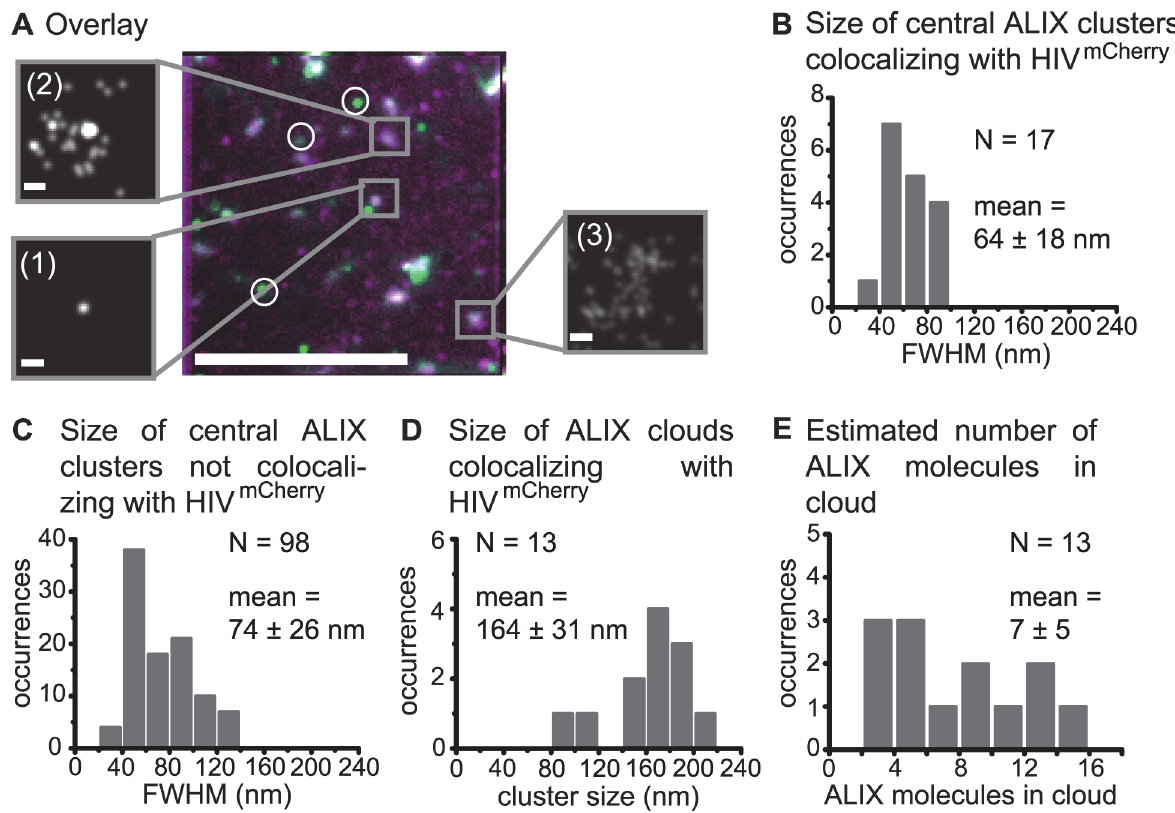
Fig 3. Super-resolution imaging of endogenous ALIX at HIV-1 assembly sites. HeLa cells were transfected with HIV:HIV mCherry and endogenous ALIX was immunostained at 14 – 15 h post transfection. Cells were imaged by TIRFM. ( A ) A time projected image of ALIX (green) overlaid with TIRF image of HIV mCherry assembly sites (magenta) is shown. Circles indicate non-colocalizing ALIX clusters and the rectangles highlight different colocalized ALIX classes. The crops show drift-corrected super-resolution STORM images of the three identified object classes: condensed ALIX structures without a surrounding cloud (1), ALIX structures with a central, condensed spot surrounded by a cloud-like structure (2) and diffuse ALIX membrane assemblies without a central spot (3). Scale bars: 10 μ m (large image), 100 nm (crops). ( B ) Size distribution of all central spots of colocalizing ALIX protein clusters with an average cluster size (FWHM) of 64 ± 18 nm. ( C ) Size distribution of all central spots of non-colocalizing ALIX protein clusters with an average cluster size (FWHM) of 74 ± 26 nm. ( D ) Cloud cluster size characterization for all cloud structures of ALIX colocalizing with HIV mCherry obtained by Ripley ’ s cluster analysis with an average diameter of 164 ± 31 nm. ( E ) The distribution of the minimum number of ALIX proteins detected per cloud estimated from the super- resolution data.